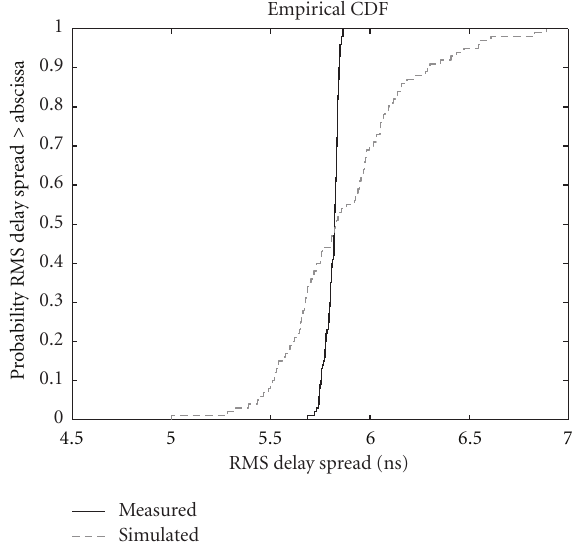
Figure 17: CDF of the RMS delay spreads of the measured and simulated channels for Rx17 (LOS) in the UWB